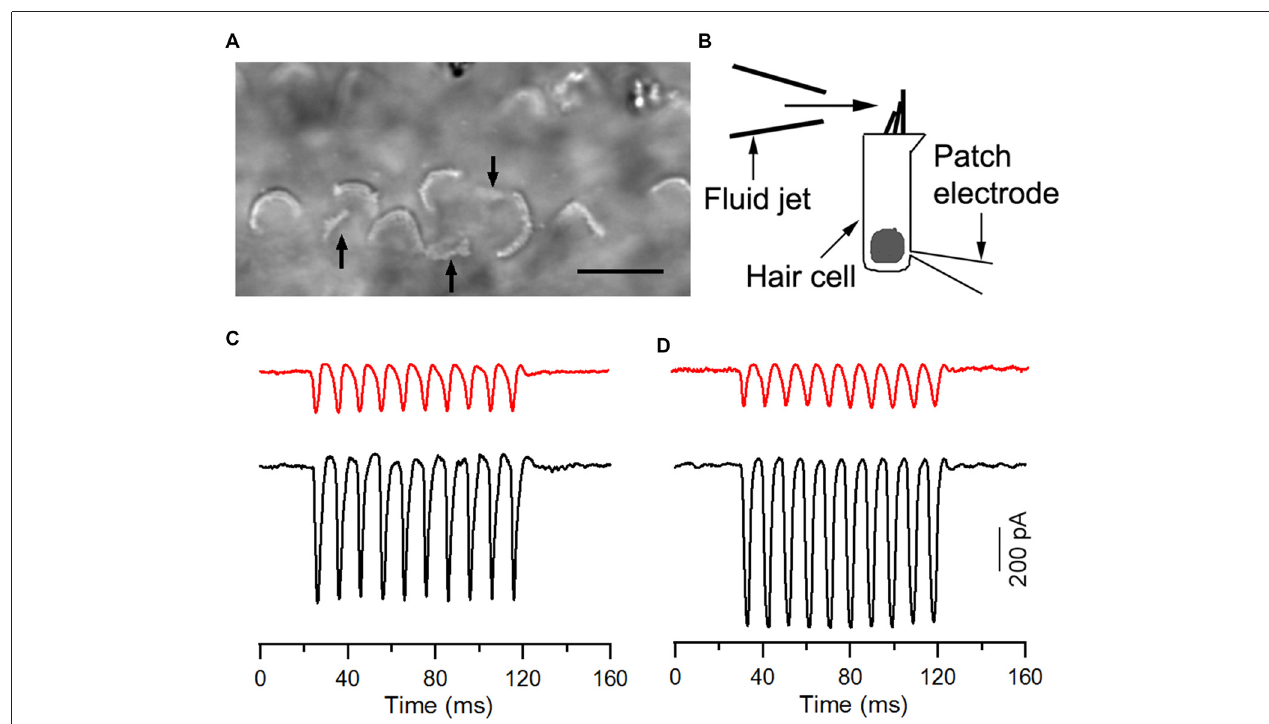
FIGURE 5 | Mechanotransduction (MET) currents recorded from ectopic hair cells. (A) Image of stereocilia bundles under bright field illumination with a water-immersion objective (63 × , NA: 0.85). Arrows indicate ectopic bundles (from HCLCs), which appeared smaller in size with no obvious “V” shape. We avoided recording from any cells when their identity was ambiguous. (B) Schematic drawing of recording MET from cultured hair cells using the whole-cell voltage-clamp technique. The bundle was stimulated with the fluid jet. (C) Representative MET currents recorded from an HCLC (red) and an IHC (black) in the IHC region. (D) MET currents recorded from an HCLC (red) and an OHC (black) in the OHC region. Recordings were made from 8-day-old